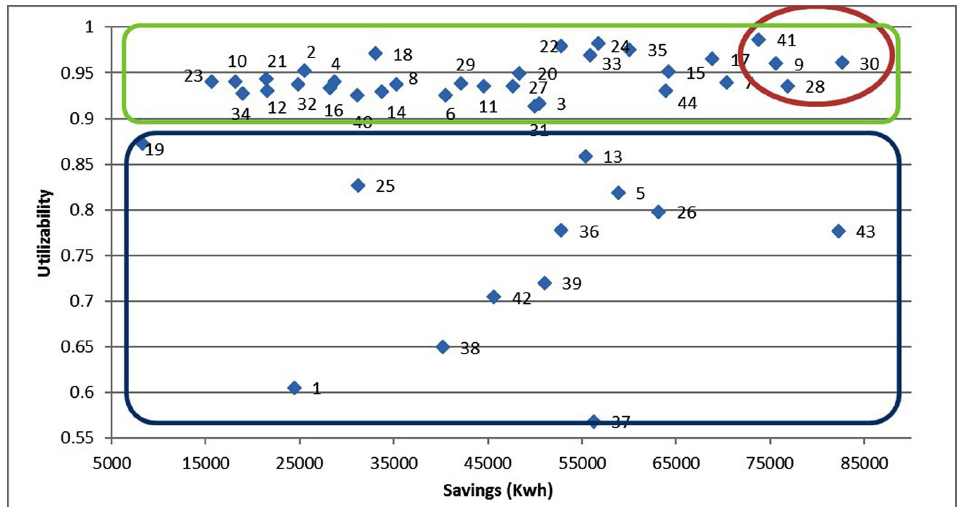
Fig. 4. Utilizability versus energy savings of the 44